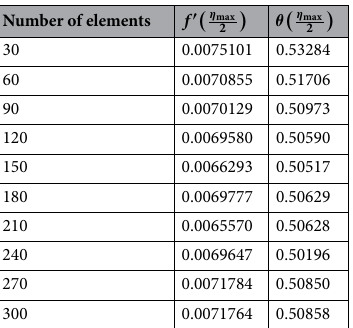
Table 2. Simulations for mesh-free in temperature and velocity observing 300 elements 38 when 0.003, ϕ 1 = 0.3, (cid:31) 0.7, γ 1.5, Fr 0.53, Pr 204, Hs 1.7, (cid:31) 1.3, δ 2.0, ϕ 1 ε ∗ = = = = = = = = =